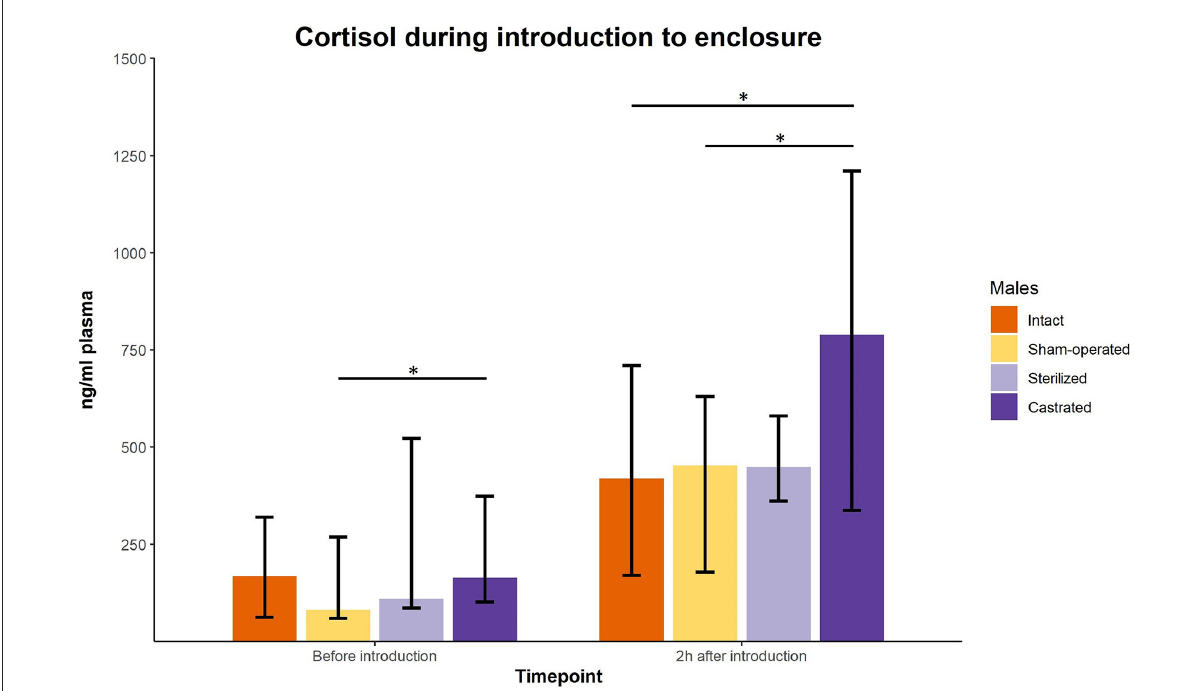
FIGURE2 Cortisol concentrations in ng/ml plasma of intact, sham-operated, sterilized and castrated males before and shortly after introduction (1 male and 2 females were put together in a new enclosure). Data are presented as medians, minimum and maximum values. Before introduction: blood sample taken just before start of experiment; 2h after introduction: blood sample taken 2h after introduction in the new enclosure. Statistics: Kruskal-Wallis tests, post-hoc Holm-Bonferroni corrected Mann-Whitney U -Tests. N intact = 10, n sham − operated = 8, n castrated = 14, n sterilized = 4. * p < 0.05 (after Holm-Bonferroni correction).